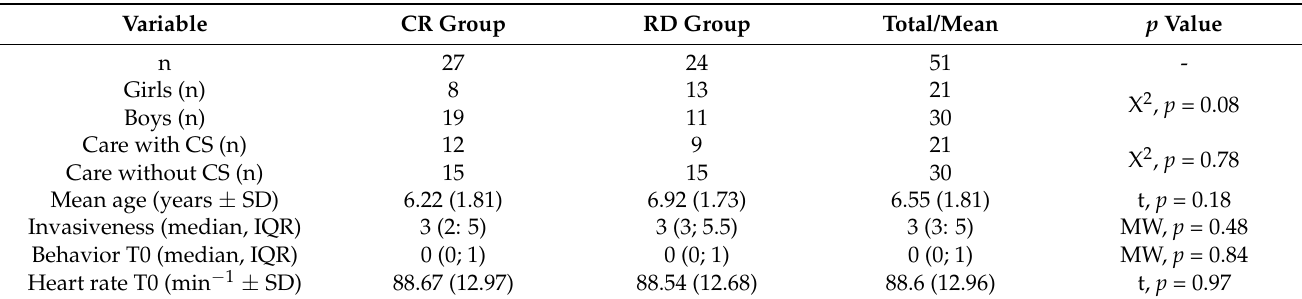
Table 1. Overview of the cohort properties, per total of patients or different subgroups at start of the experiment. Difference between CR and RD groups were tested, and results are given with the applied test (X2: chi2, t: student’s t -test, MW: Mann–Whitney